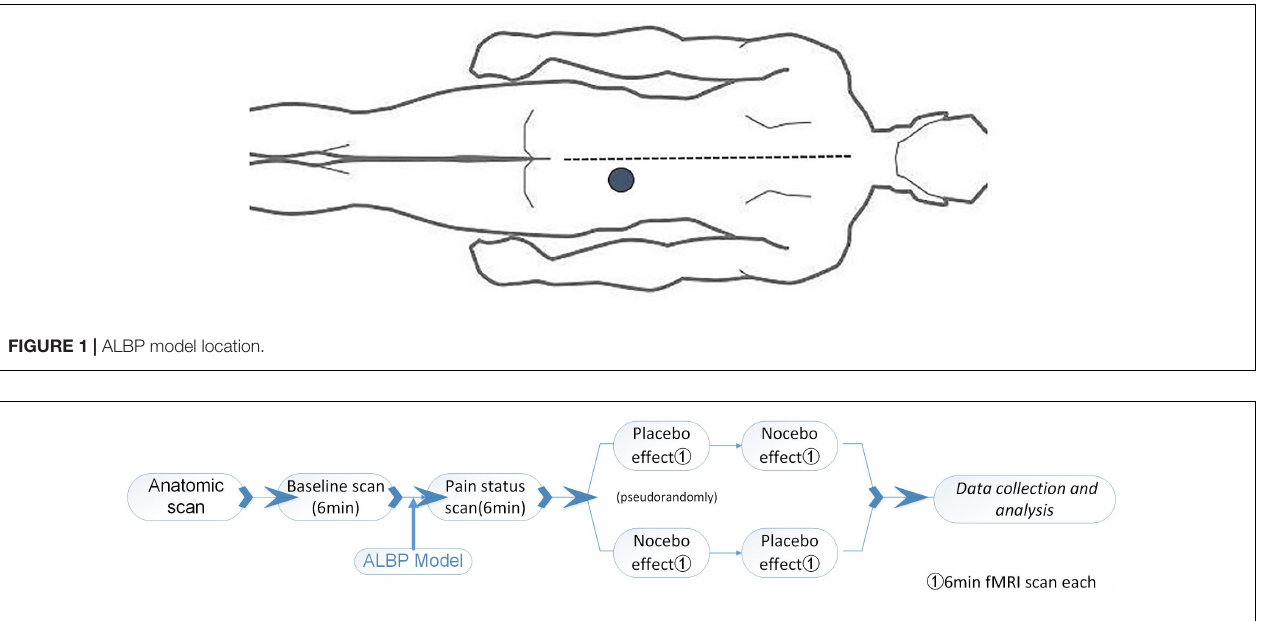
FIGURE 2 | The experimental paradigm for the participants.